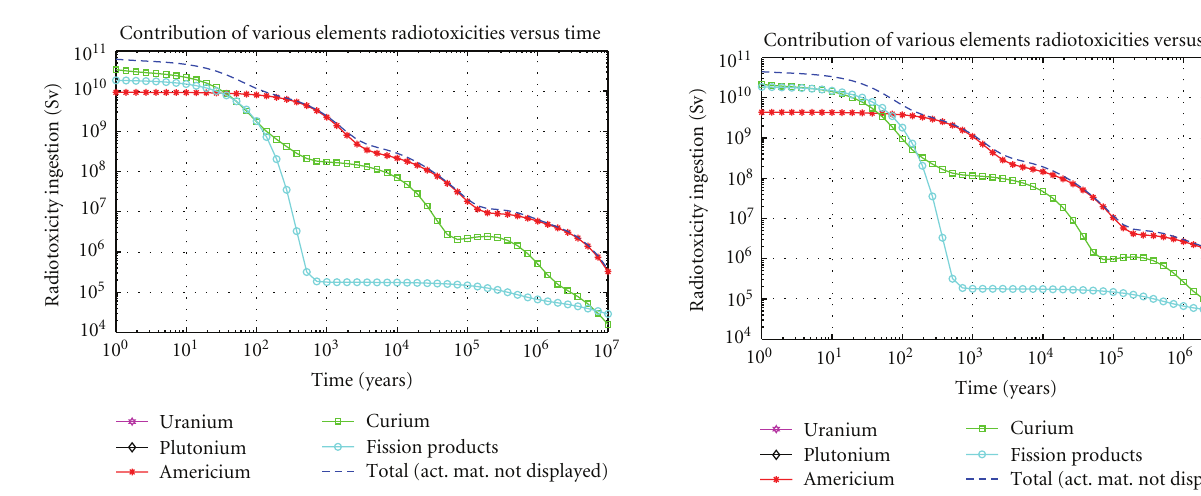
Figure 18: Contributions to radiotoxicity versus time—PBMR SNF.